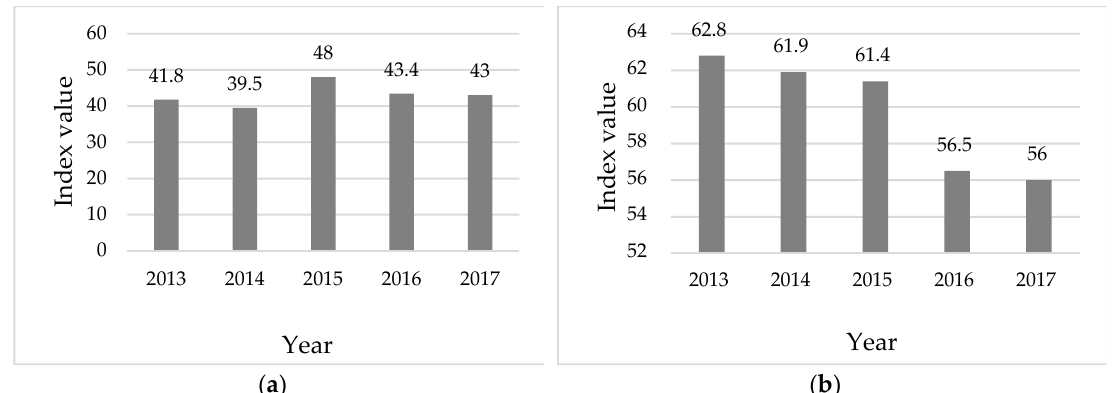
Figure 16. The indicator values: ( a ) The severity index, Ig and ( b ) average duration index for the 2013 period in Romania [2].